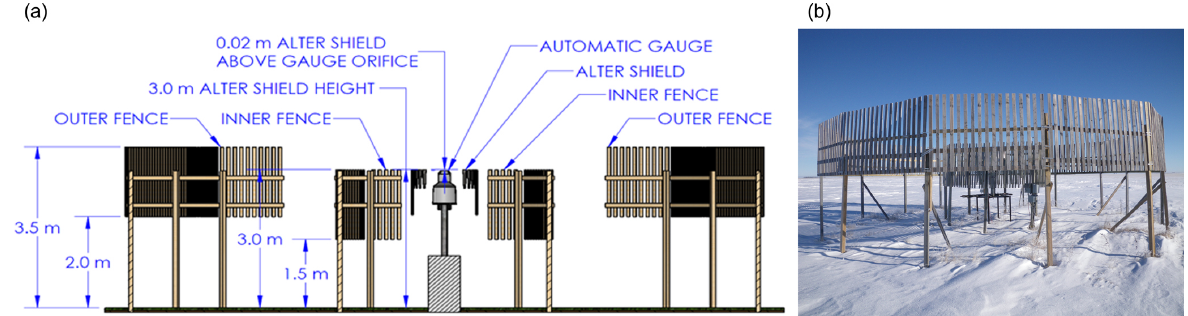
Figure 1. Conceptual diagram ( a ; Nitu and Roulet, 2016; diagram courtesy of Jeff Hoover, Environment and Climate Change Canada) and photo ( b ; Bratt’s Lake) of the WMO DFAR.